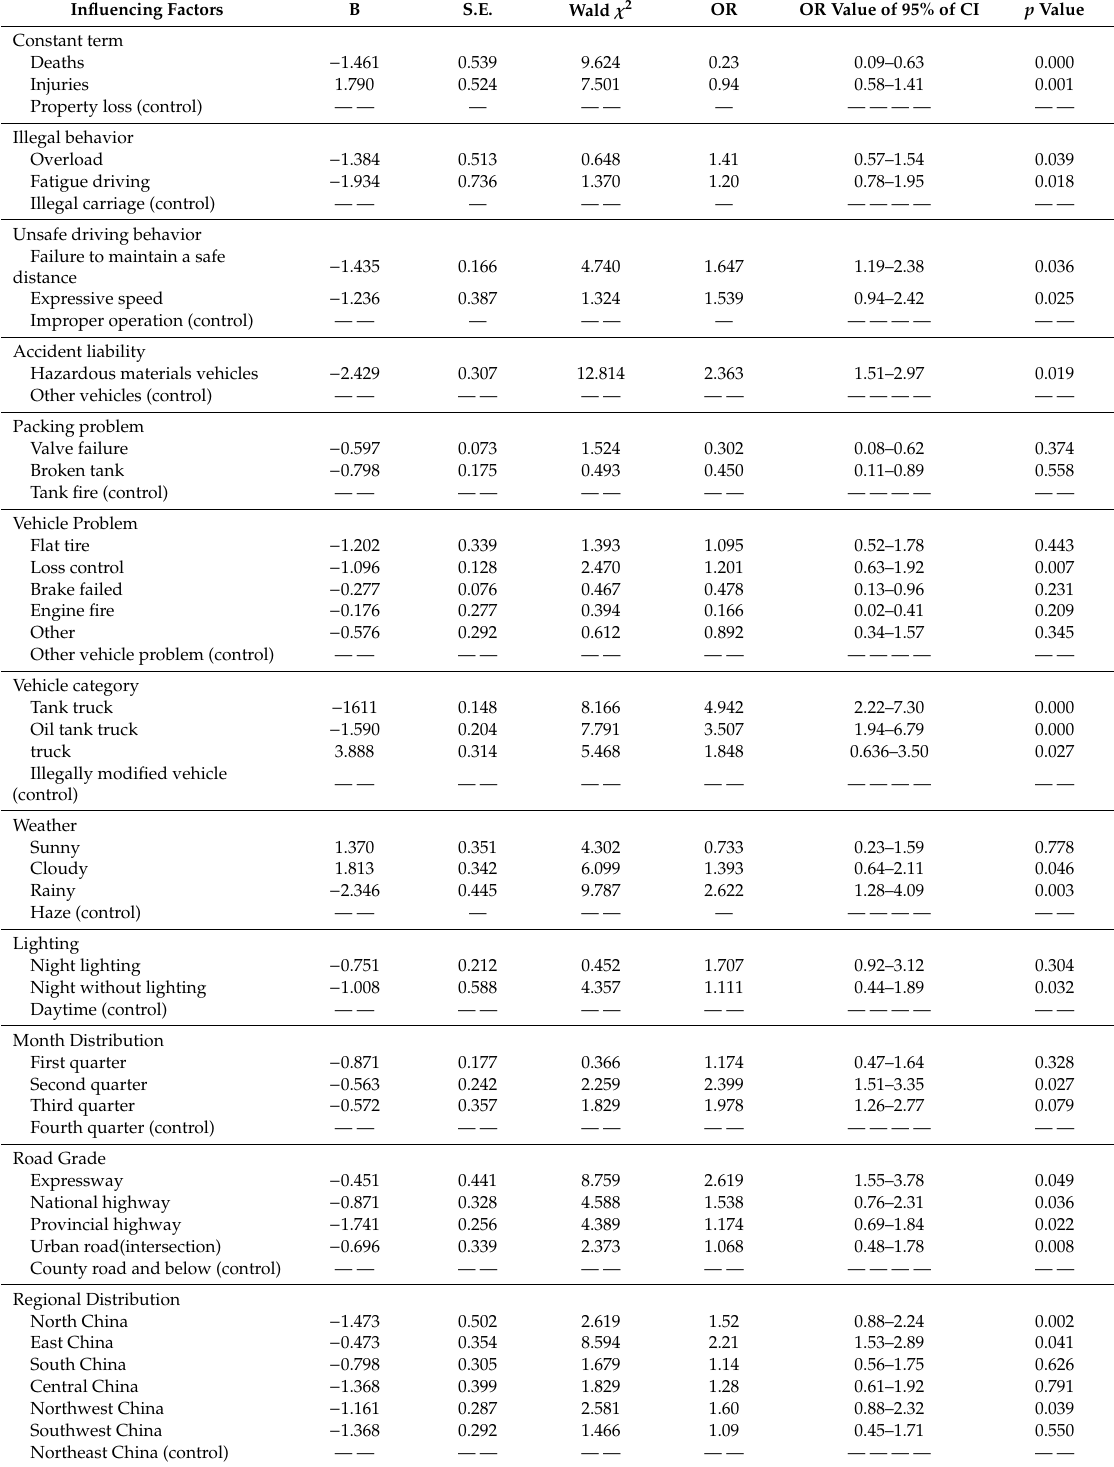
Table 3. Analysis results of ordered multiple classification Logistic